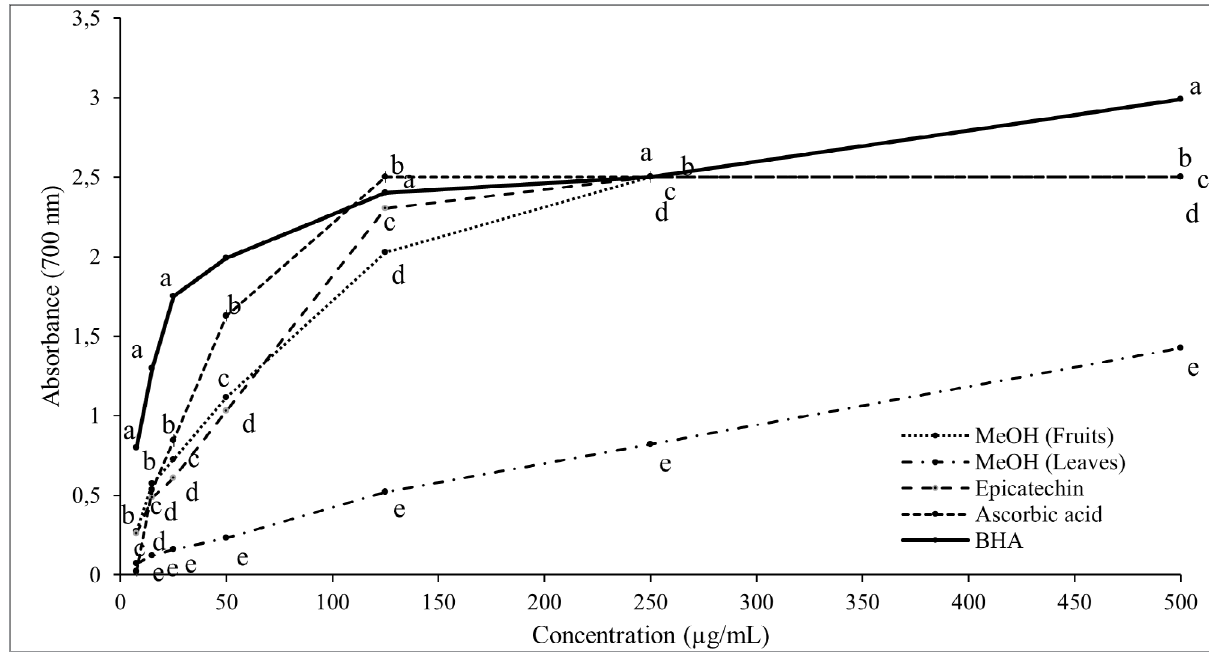
Figure 3: Reducing power of the MeOH extract of Ficus sur (fruits and leaves), epicatechin, ascorbic acid and butylated hydroxyanisole (E320) (BHA). Values with different letters for a given concentration of each extract and compound are significantly different from each other (Tukey’s HSD multiple range post-hoc test, p